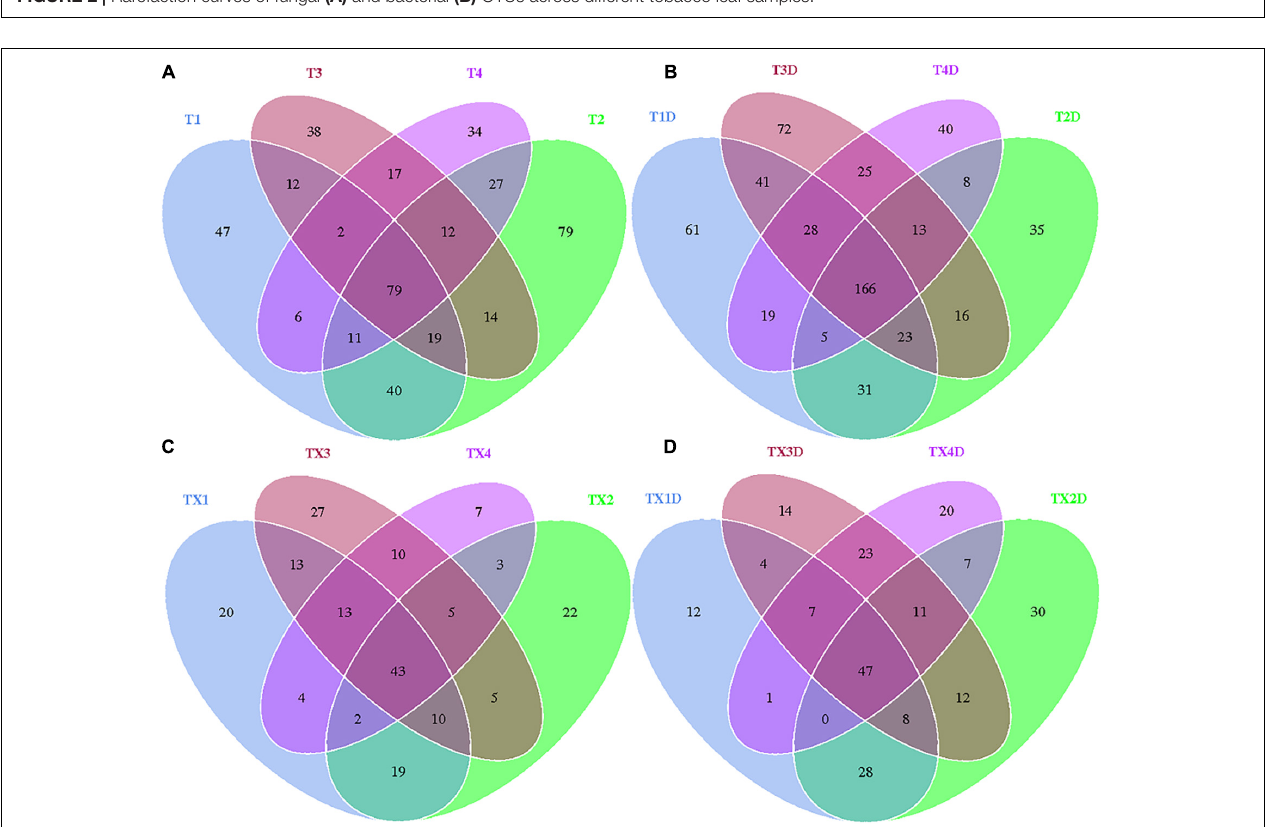
FIGURE 3 | Venn diagram showing the number of fungal and bacterial OTUs detected in different groups at four different disease severity. Fungal Venn diagram in diseased (A) and healthy (B) groups at four different disease severities. Bacterial Venn diagram in diseased (C) and healthy (D) groups at four different disease severities. Numbers in the core section indicated shared OTUs for each group at four different disease severities. Numbers in the overlapping region indicated unique OTUs for two or three samples. Numbers in the non-overlapping regions indicated unique OTUs for the